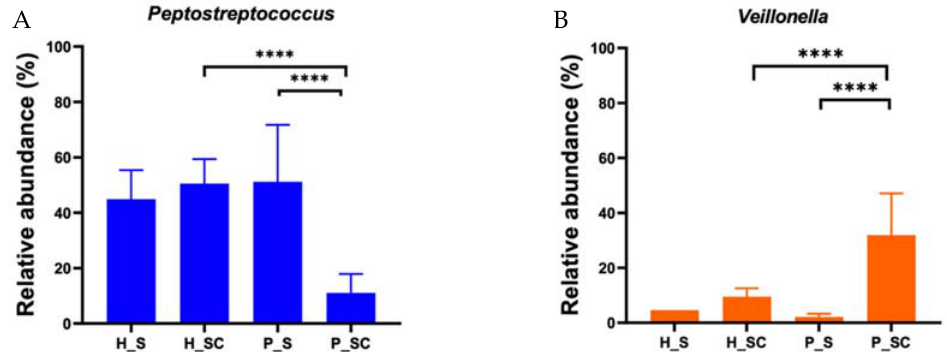
Figure 7. Relative abundance of ( A ) Peptostreptococcus (blue bar plots) and ( B ) Veillonella (orange bar plots) in eDNA. The bar plots represent the mean of relative abundance of the respective genus in the biofilms derived from two periodontally healthy and two periodontitis patients in both SHI (_S) and SHI + 5 mM CaCl 2 (_SC). Error bars represent standard error of mean (SEM). **** Represents p ≤ 0.0001.